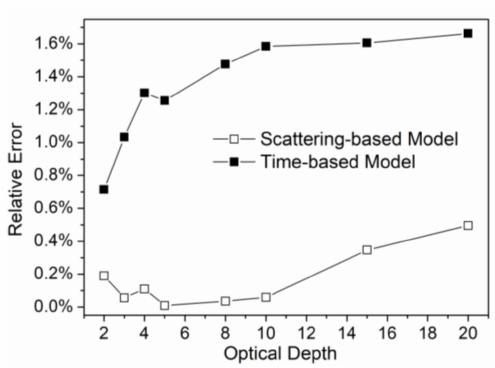
Figure 3. Relative error as a function of the OD . The transmitted value at the bin of 135 ◦ (the maximal value for backpropagated, transmitted photons) was used for comparison. Monte Carlo data was used as the ground